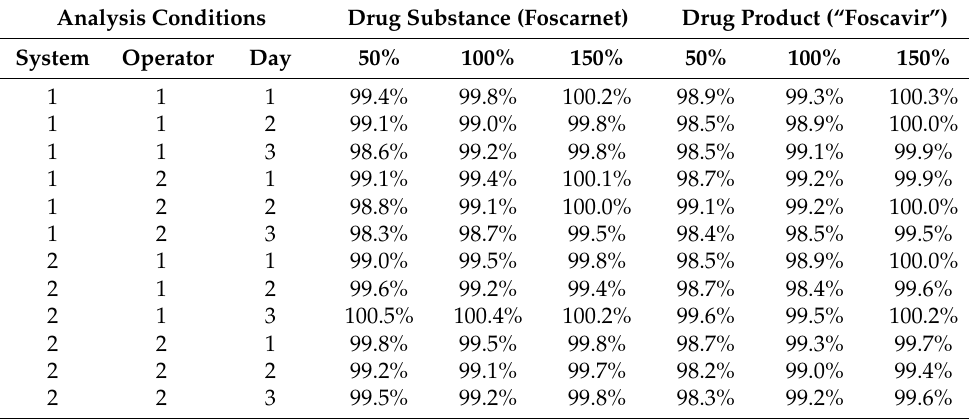
Table 8. Recovery at various conditions during validation of assay intermediate